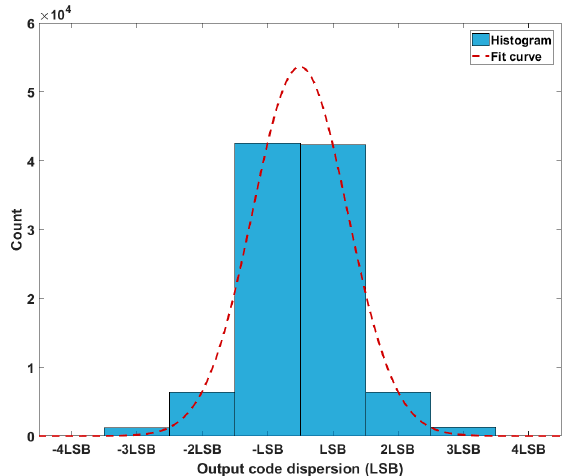
Figure 14. Output code dispersion for a 600.03 mV input.